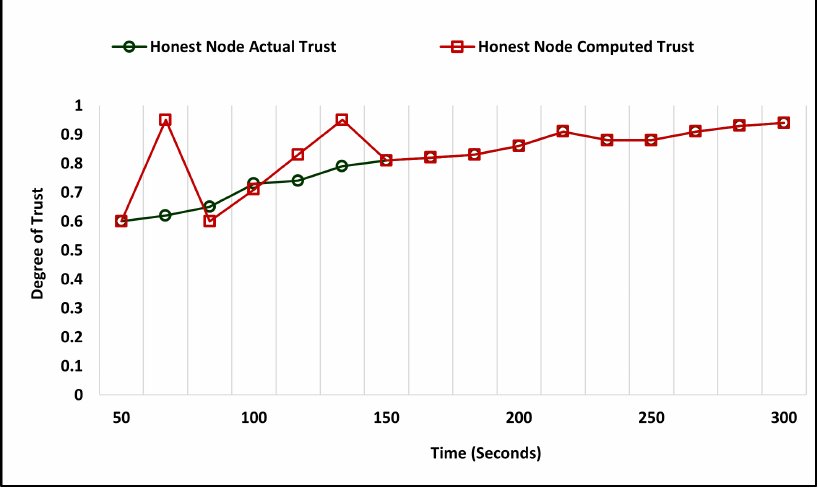
Figure 4. Honest node’s trust degree